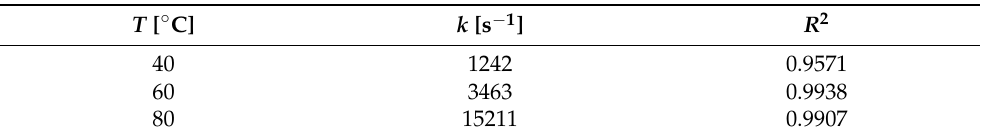
Figure A1. Data from accelerated oxidative ageing experiments with Canada balsam (as shown in Figure 11) with fitted trend lines according to Equation (A1). Table A1. Reaction rates k and correlation coefficients R 2 from the fitting of Equation (A1) to the oxidative ageing data of Canada balsam, as shown in Figure A1.